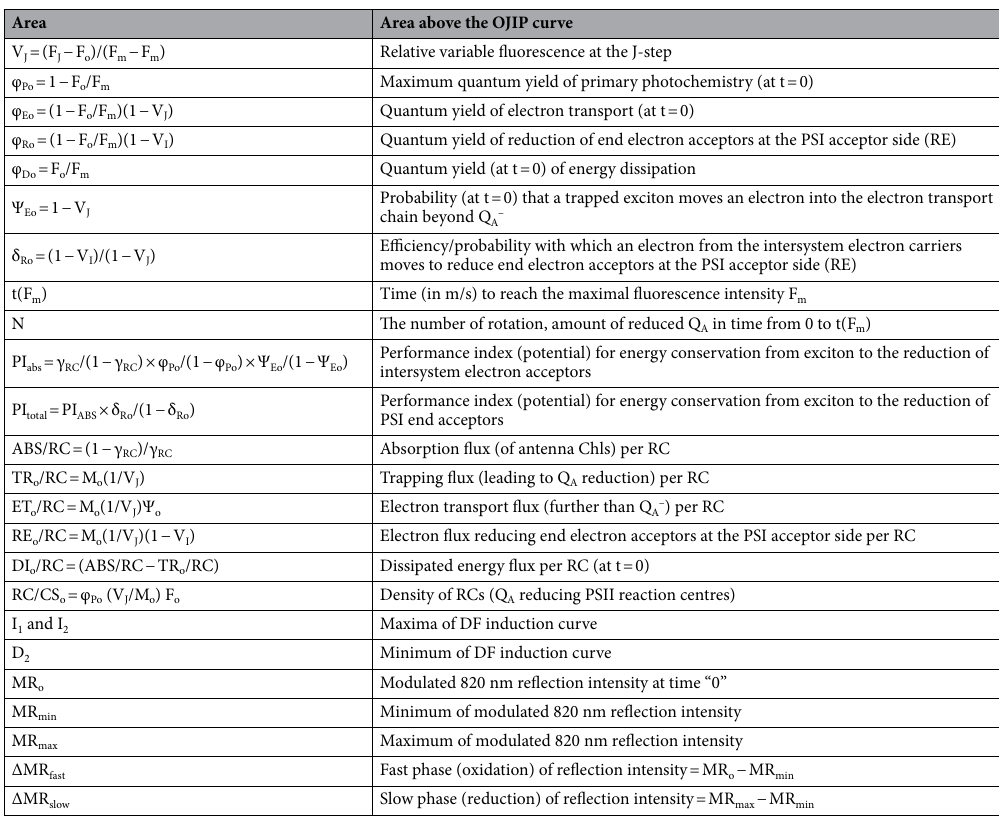
Table 6. The description of fluorescence parameters, modified from 21